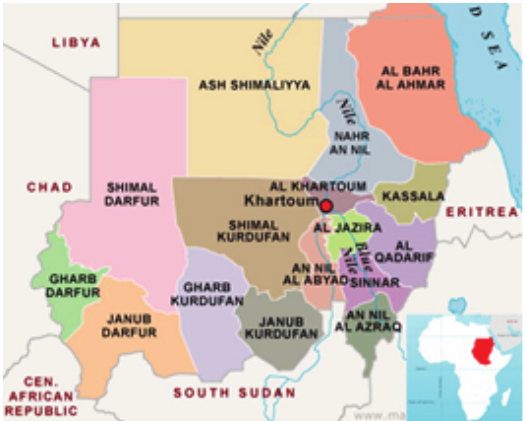
Figure 2: Map of the Republic of the